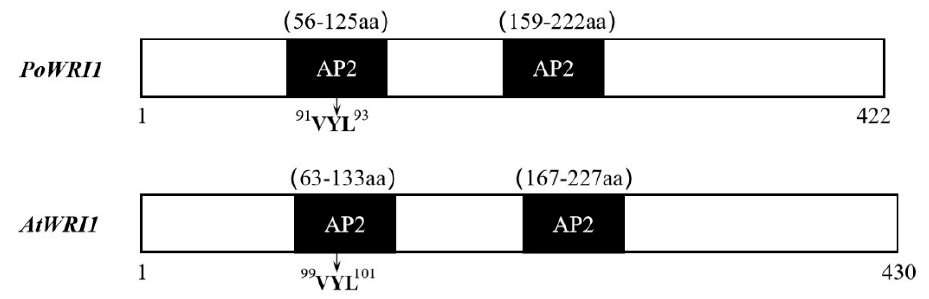
Figure 1. The structural characteristics of PoWRI1 (MW930196) and AtWRI1 (NP_001030857.1).